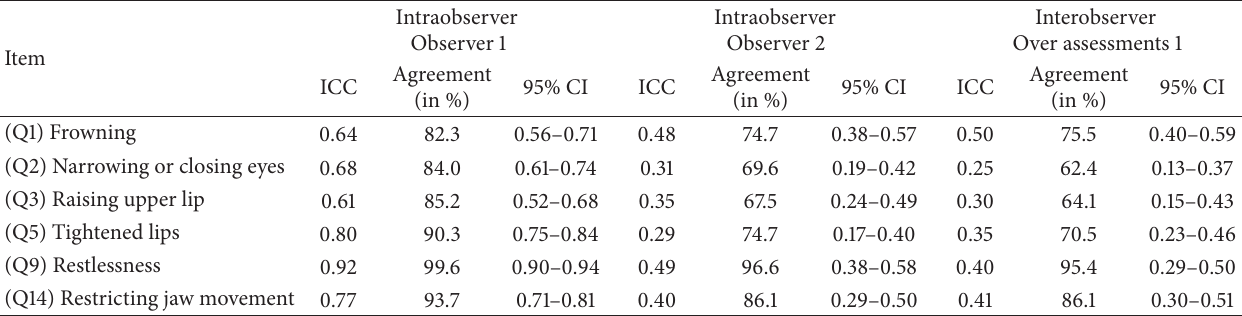
Table 3: Intraobserver and interobserver reliability per item.